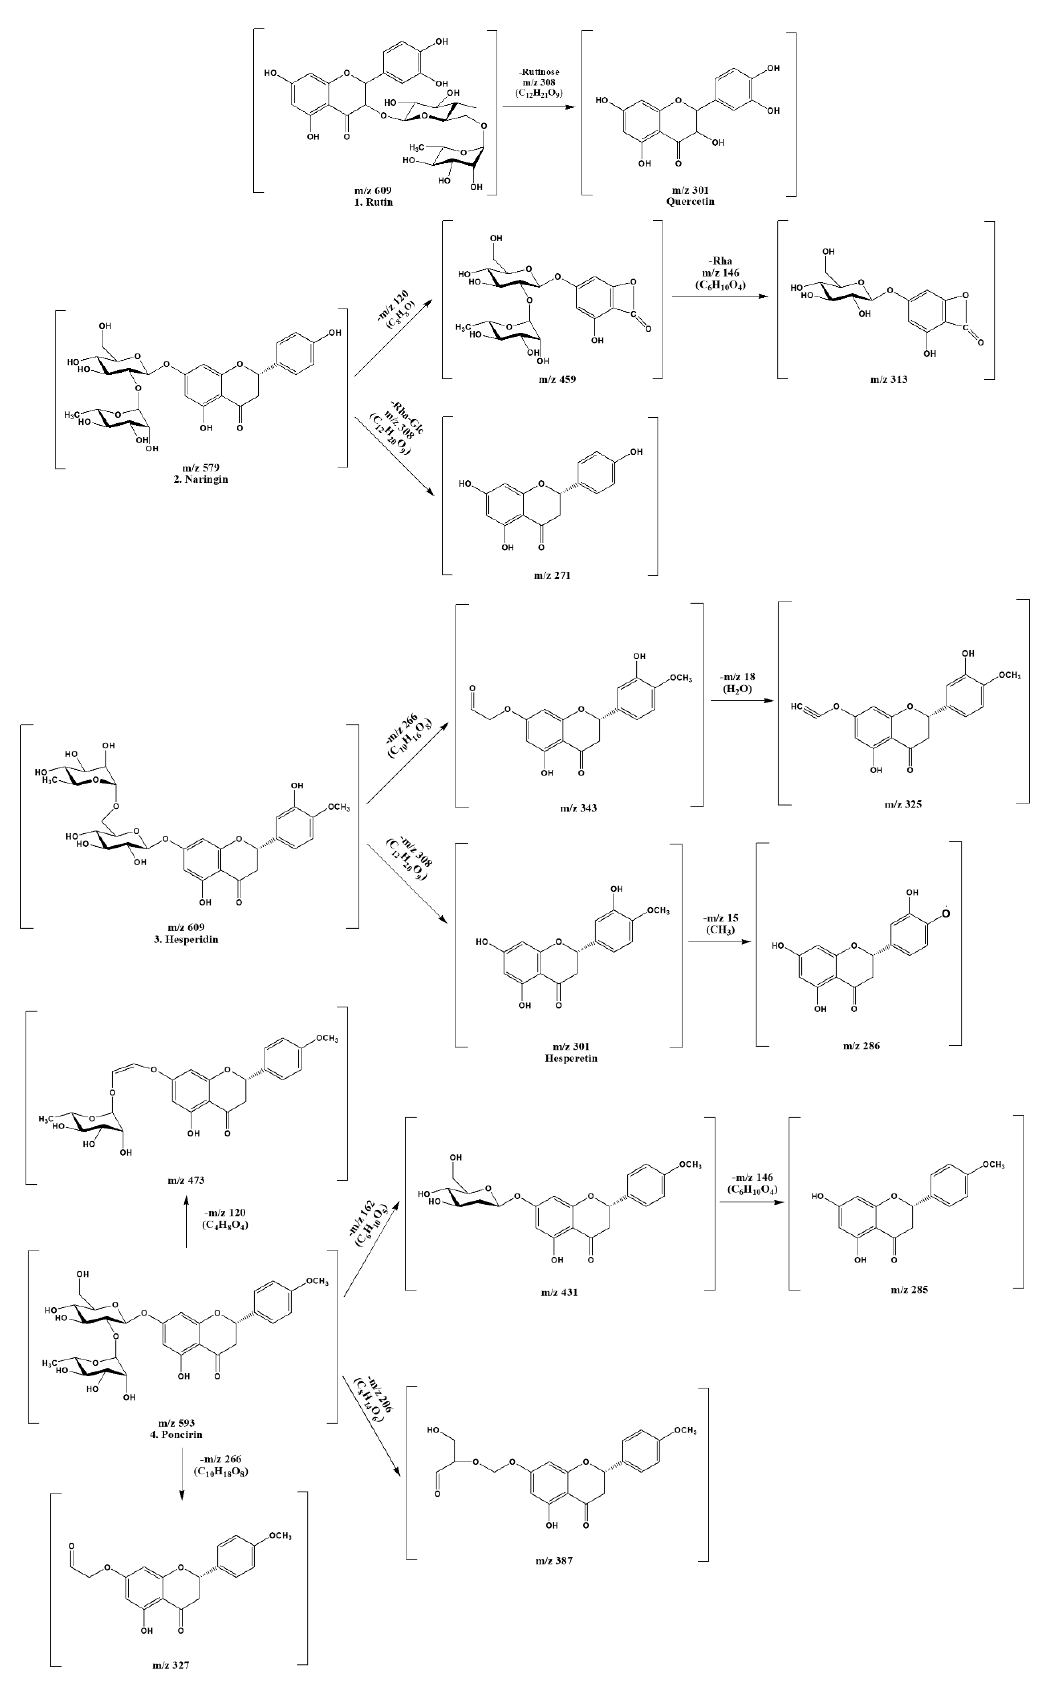
Figure 2. Fragmentation scheme of the flavonoids contained in Citrus unshiu peel.